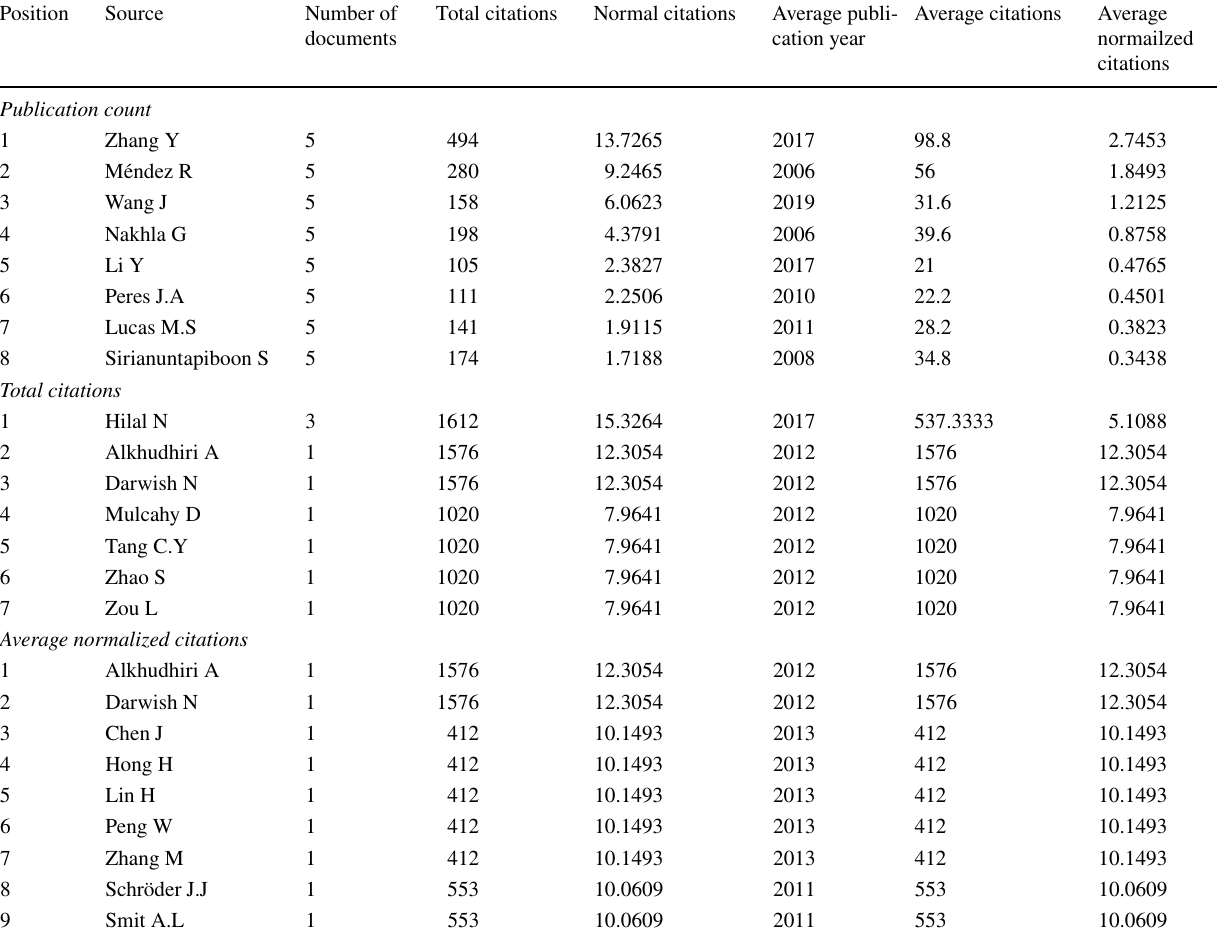
Table 3 List of leading authors in terms of publication count, total citations and average normalized citations